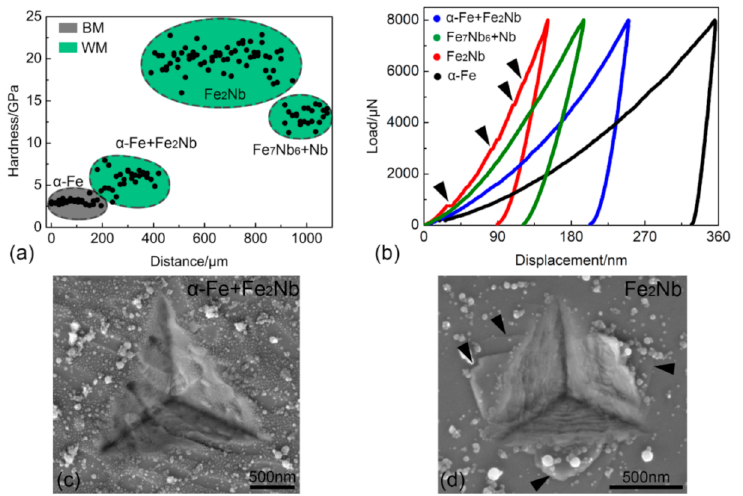
Figure 5. ( a ) Hardness distribution in the Nb welded joint; ( b ) P–h curves of typical phases; ( c , d ) α - Fe + Fe 2 Nb and Fe 2 Nb impressions,